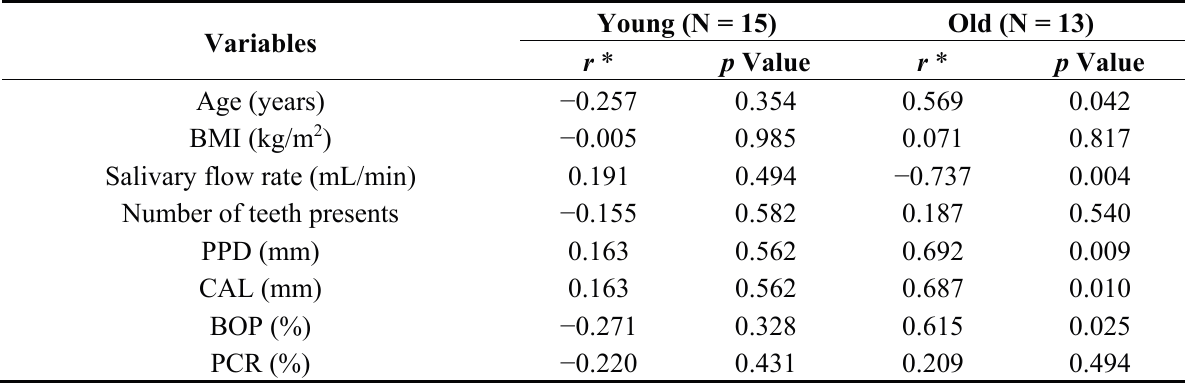
Table 3. Correlation between clinical parameters and relative expression rates for